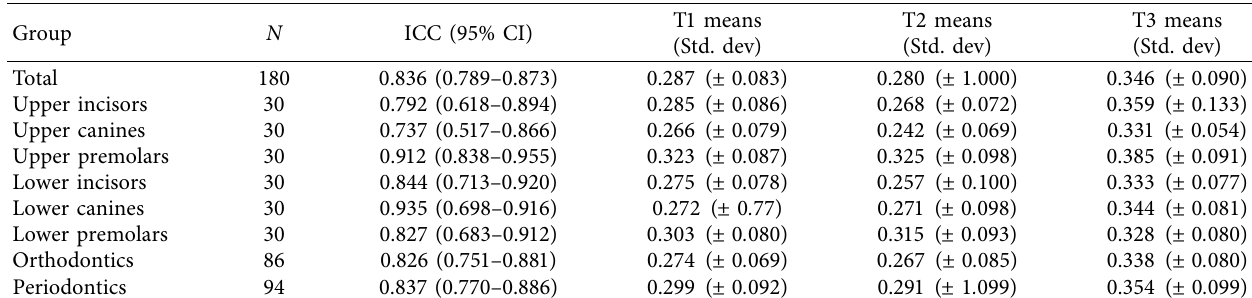
Table 7: Interrater ABT by tooth groups and clinic groups.